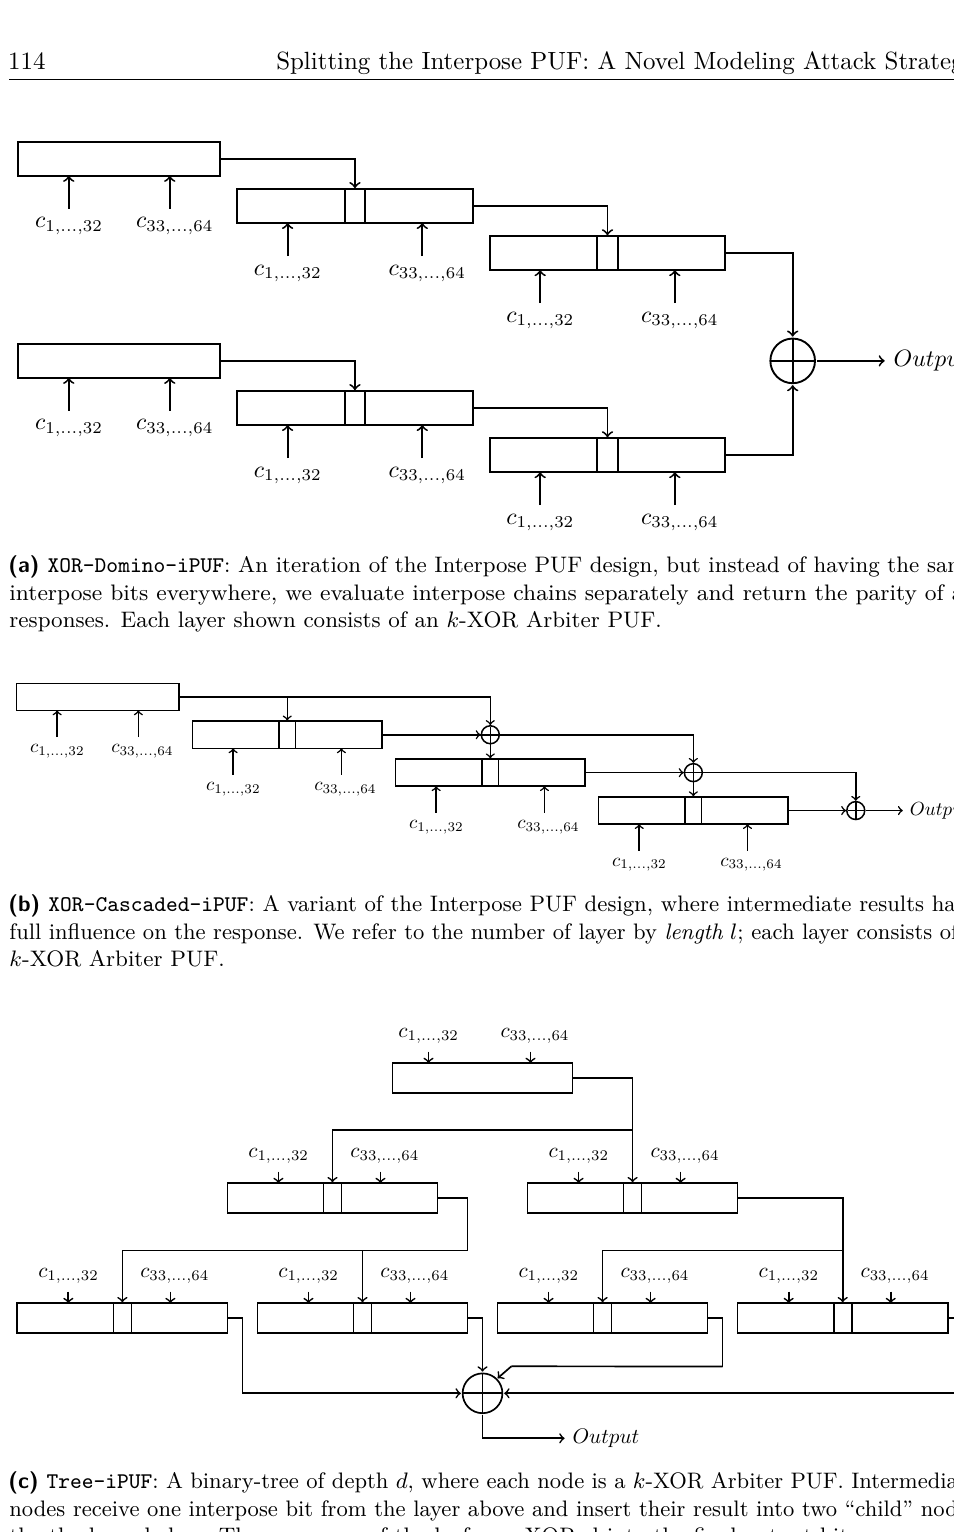
Figure 5: Variants of the Interpose PUF design. We stress that the exact ML-resilience of the presented variants may eventually depend notably on the exact interpose (or feed-in) points. All shown variants naturally follow the original iPUF design in the sense that intermediate responses are interposed/fed-in in the middle of new challenges (as in the iPUF). We remark that we did not optimize the interpose/feed-in points, or systematically study their effect on the ML-resilience of the resulting architectures in this paper